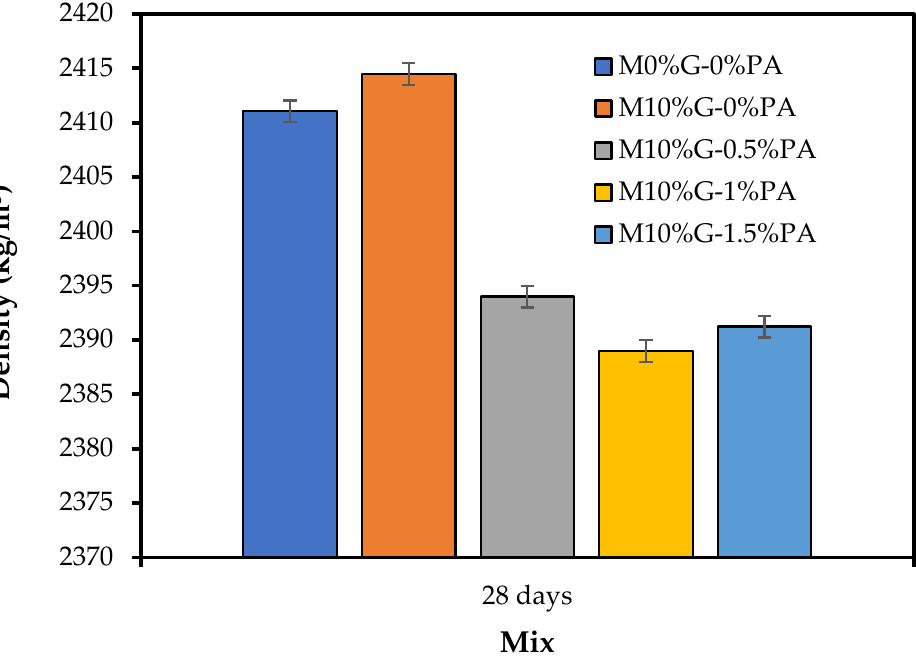
Figure 6. Density for cubes with powder glass and PA fibers (6 cubes /mix).